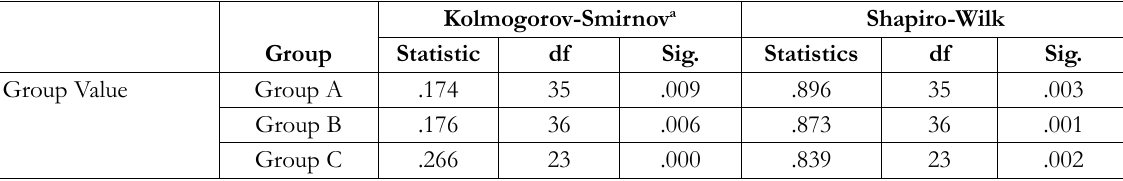
Table 5. Tests of